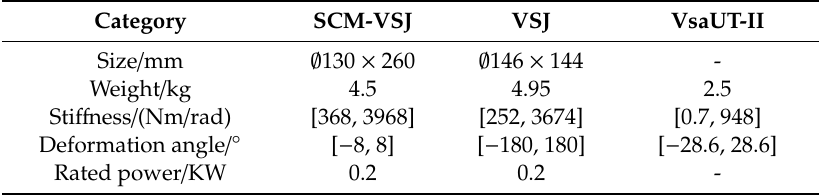
Table 3. Parameter comparison among several variable stiffness joints.